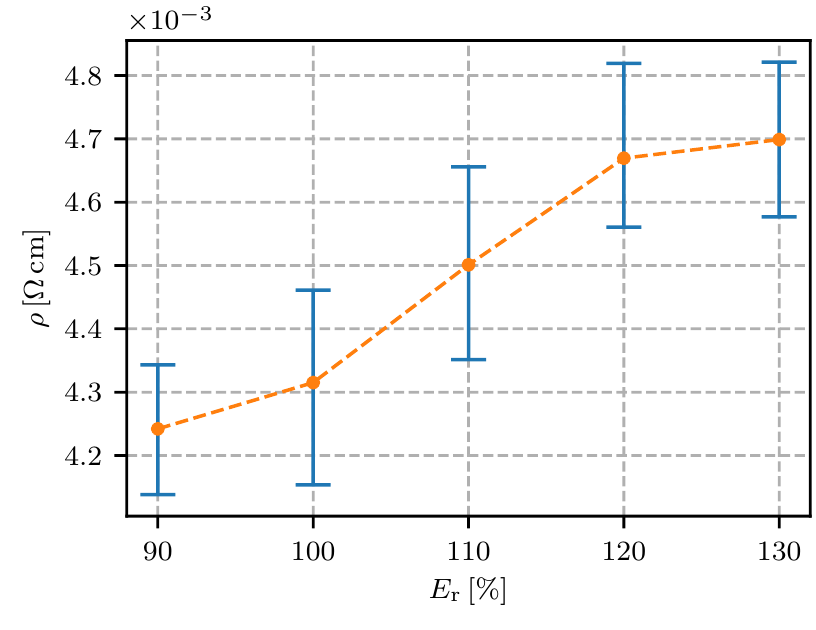
Figure 14. Resistivity for different extrusion rates E r